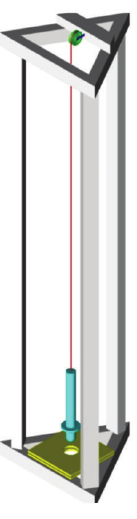
Figure 3: Impact hammer, a